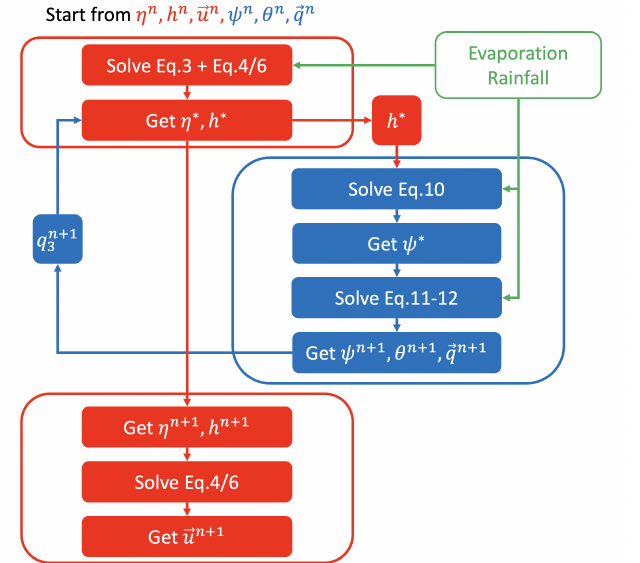
Figure 1. Model coupling between the surface and the subsurface domains from time level n to n + 1. The red boxes represent the surface domain. The blue box is the subsurface domain. Variables with superscript “*” are intermediate solutions between time n and n + 1. Only a single loop is conducted, e.g., h n → h ∗ → q n + 1 → h n + 1